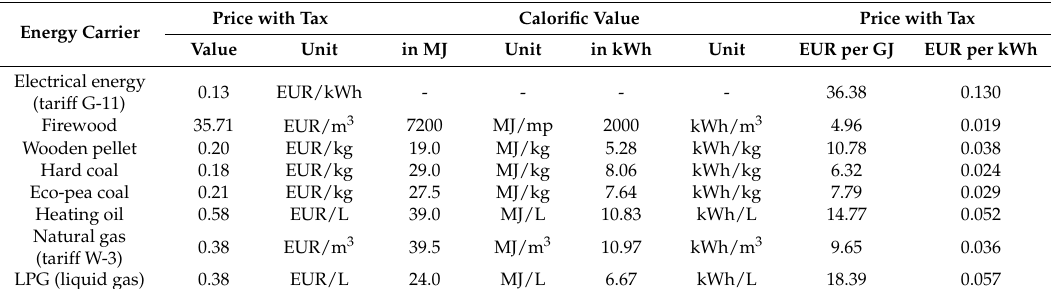
Table 4. The energy price with the tax (23%) pre GJ and kWh for chosen energy carriers [40–44].